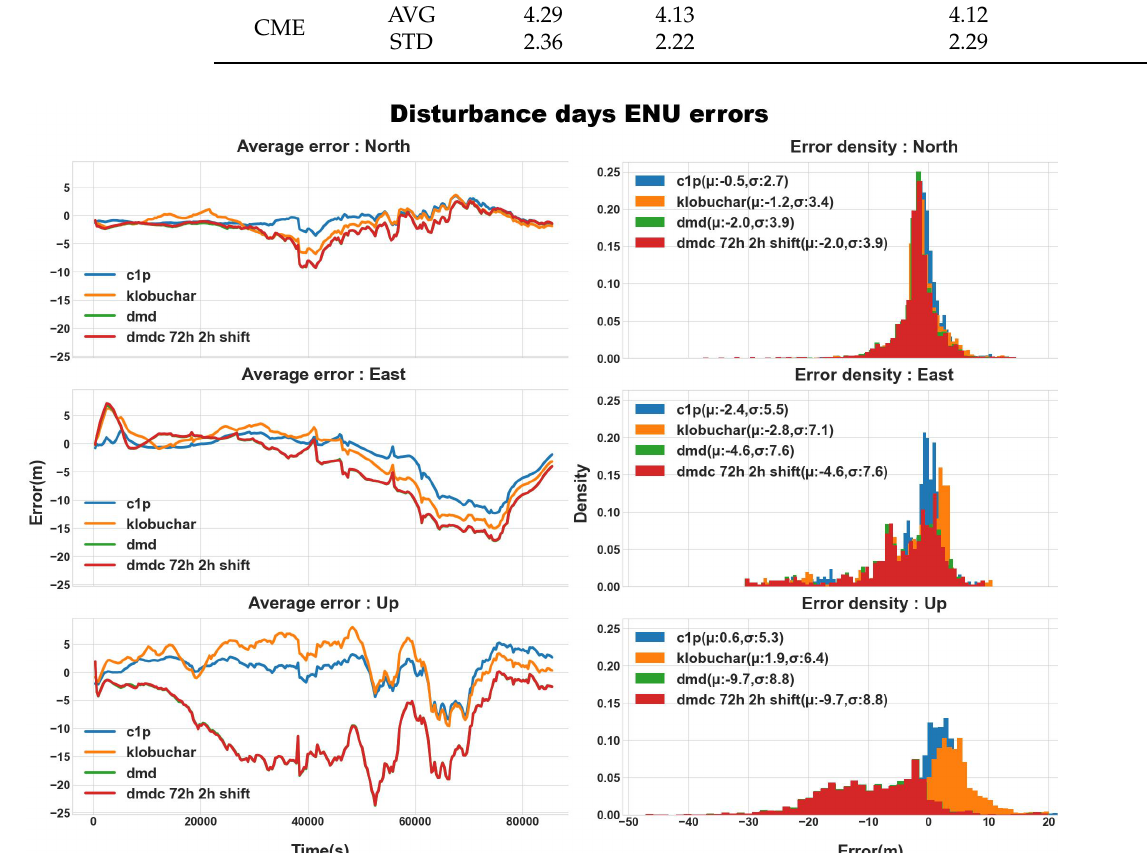
Figure 7. ENU statistics for ten disturbed solar days, estimated by the gLAB software for L1 single frequency using different Ionospheric correction sources. Left column shows the average error as a function of time. Right column shows the error